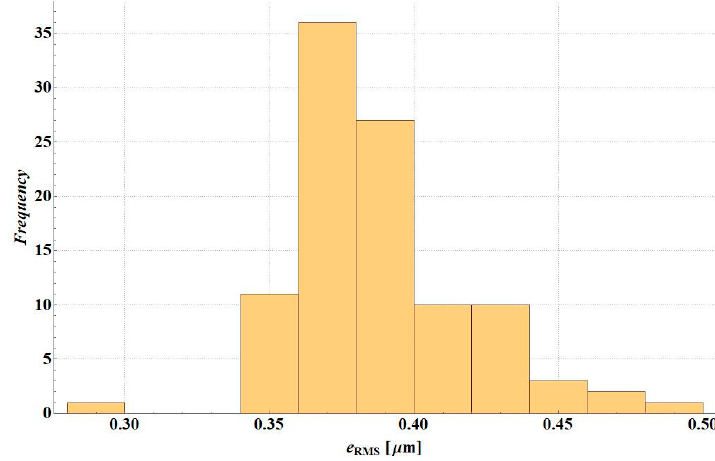
Figure 7. e RMS error histogram for D2S variant.